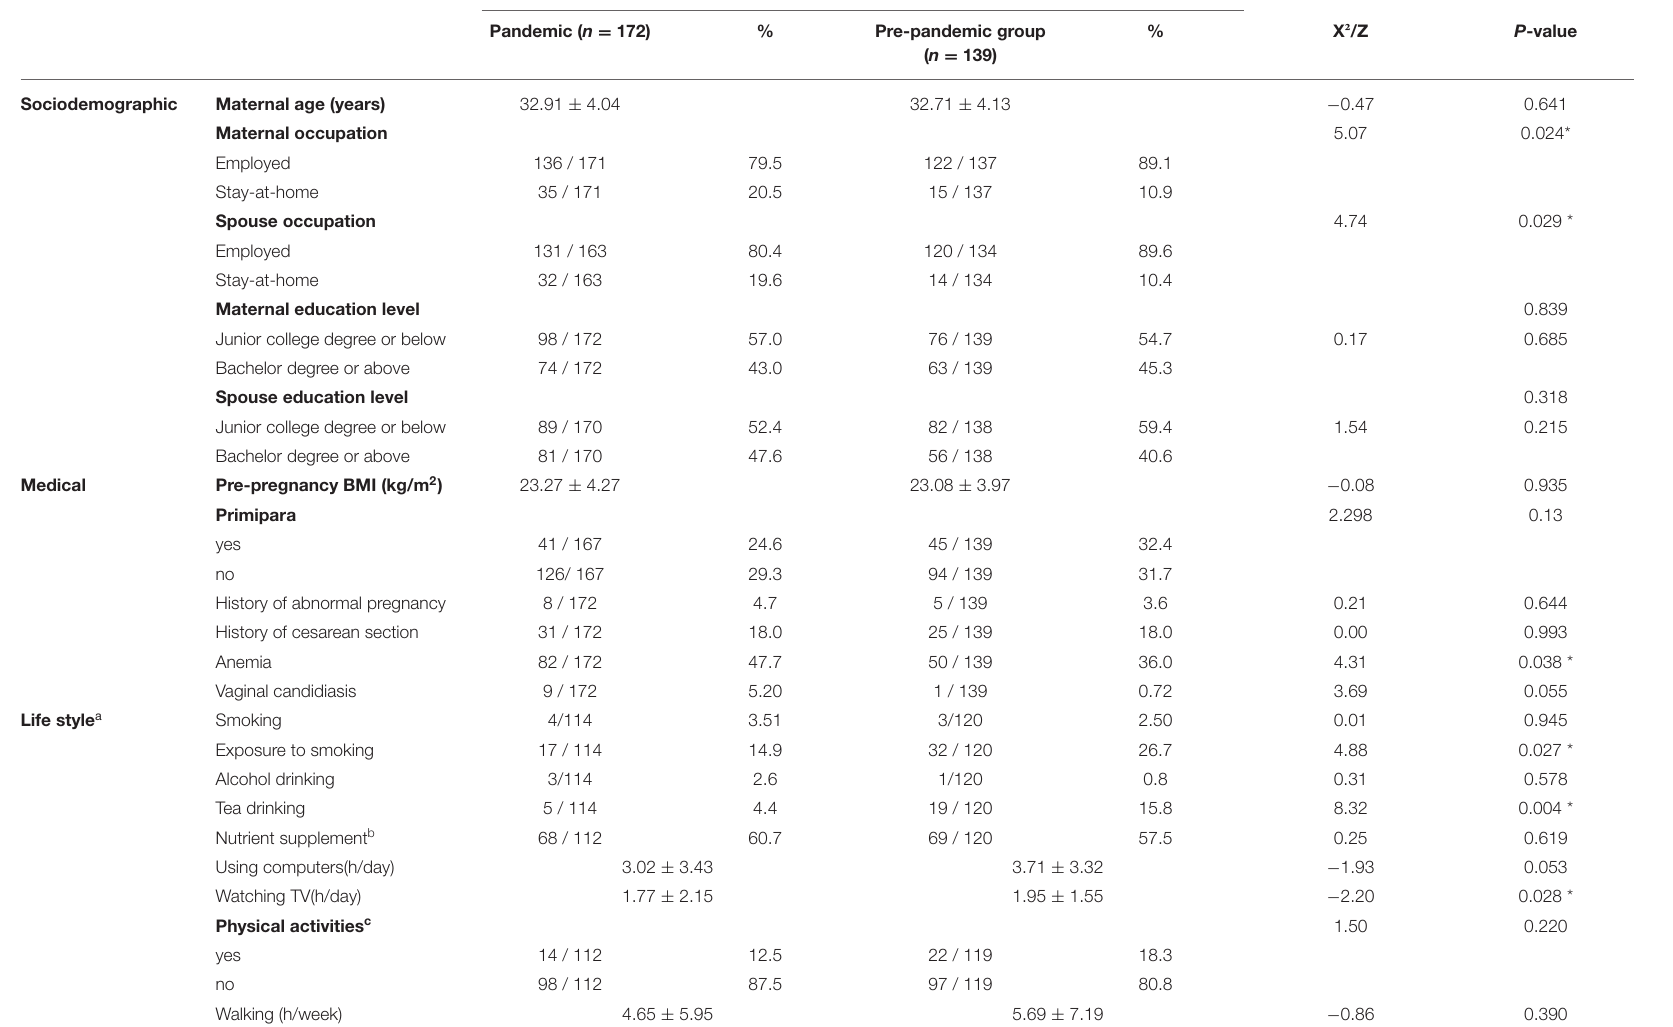
Pregnant women with adverse pregnancy outcomes, No./total No. Pandemic ( n = 172) % Pre-pandemic group % X ² /Z P -value ( n = 139)